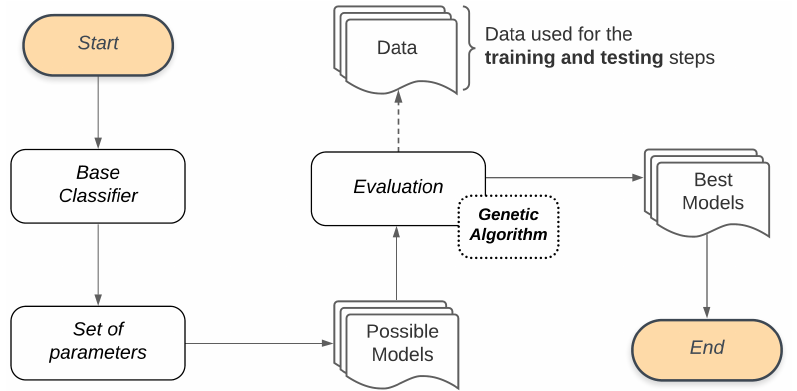
Figure 4. Model selection general